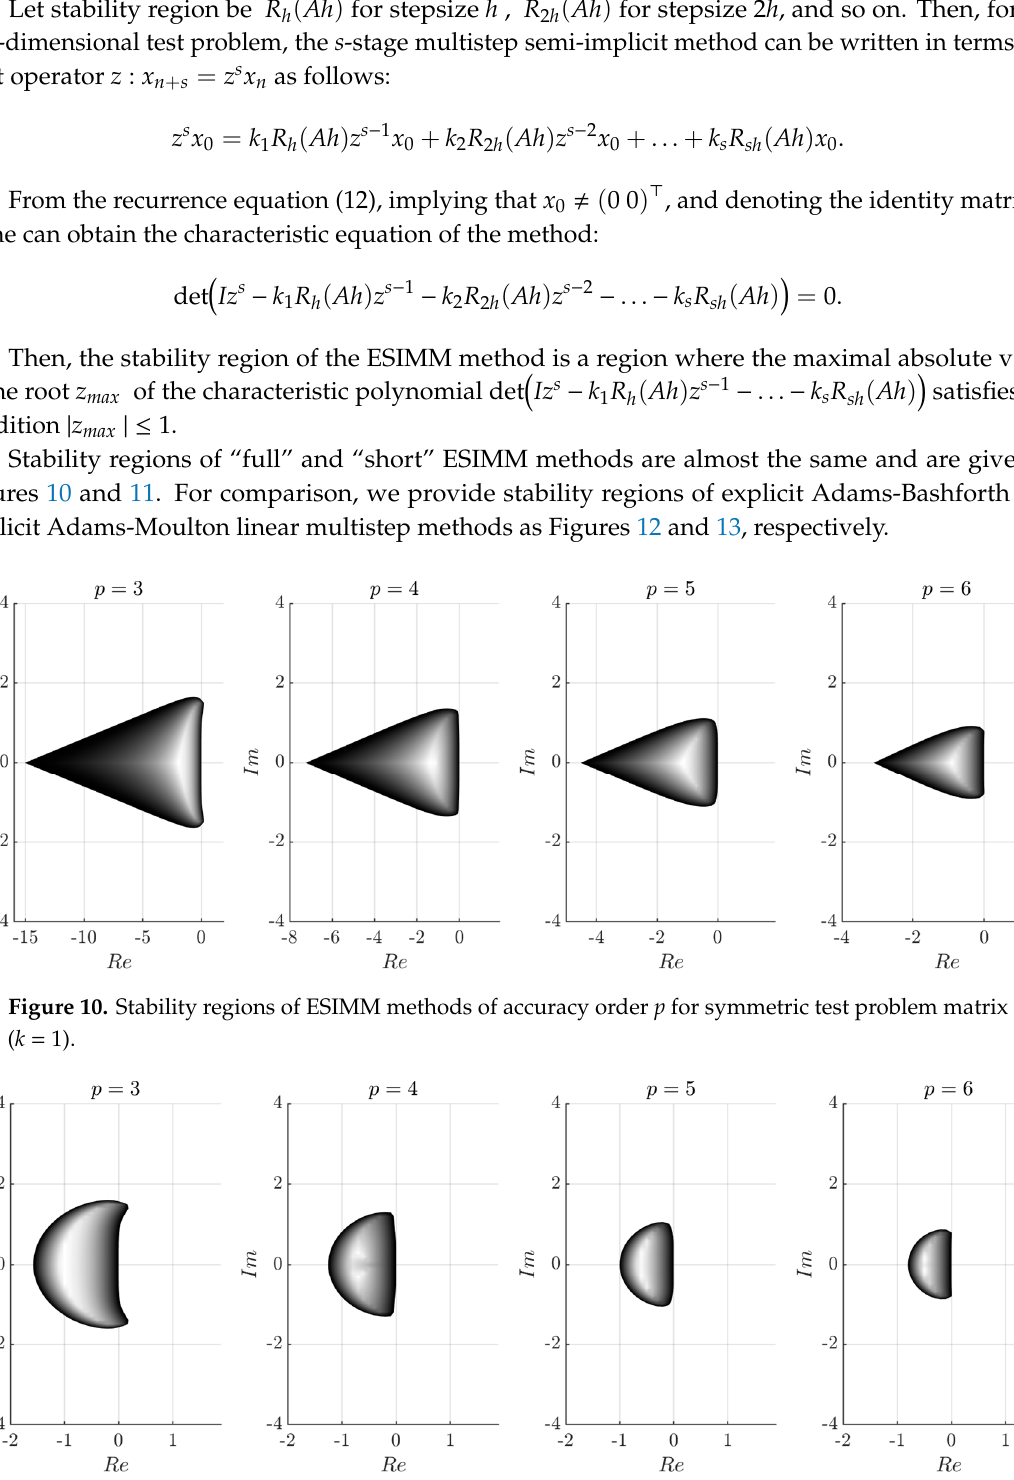
Figure 11. Stability regions of ESIMM methods of accuracy order p for asymmetric test problem matrix ( 𝑘 = 0 )